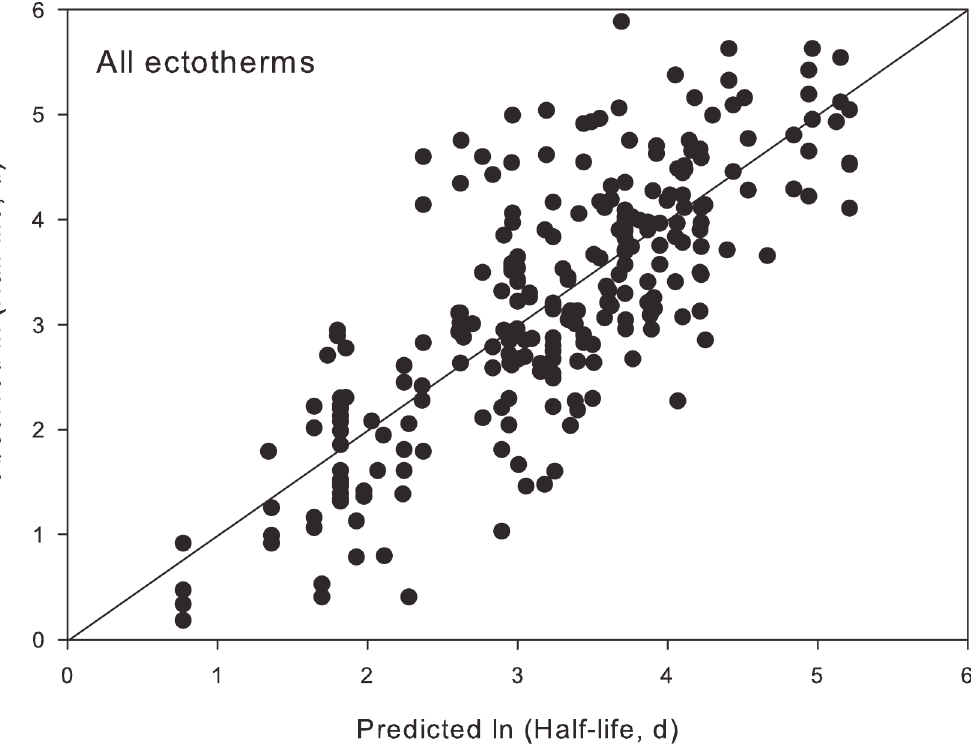
Fig 3. Predicted versus observed ln(half-life) for ectotherms from our model with a common body mass slope and group-specific intercepts (Eq. 3).